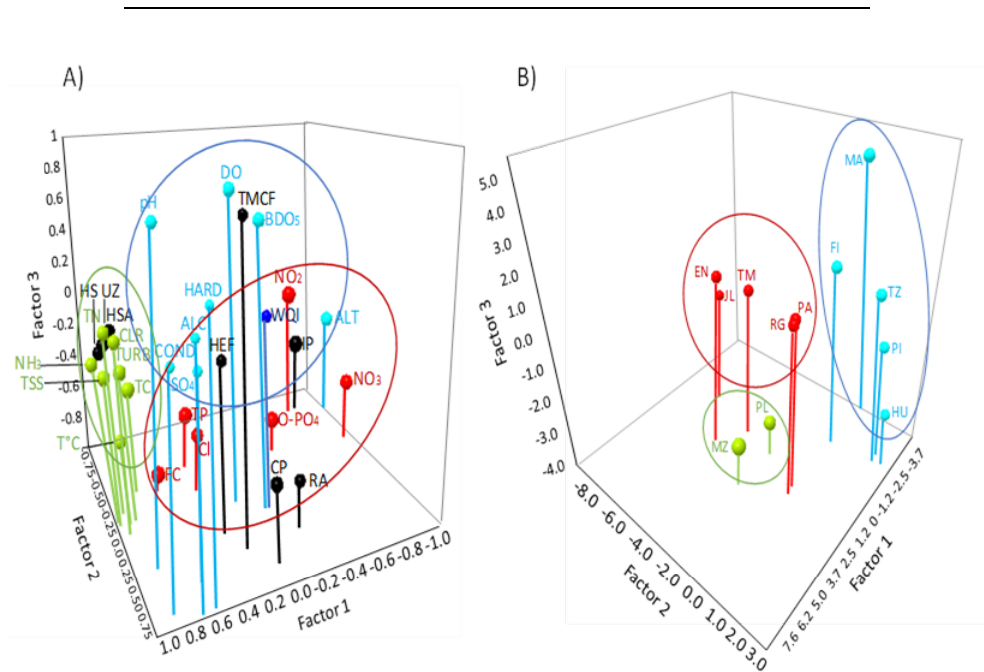
Figure 7. Principal component analysis for study sites, physicochemical variables, WQI, and land uses. ( A ) Environmental and land-use variables; ( B ) clusters of study sites. Table 2. Mean values (± Standard Error (SE)) of components related to N and P, WQI, and predominant land uses (%) for each study site.